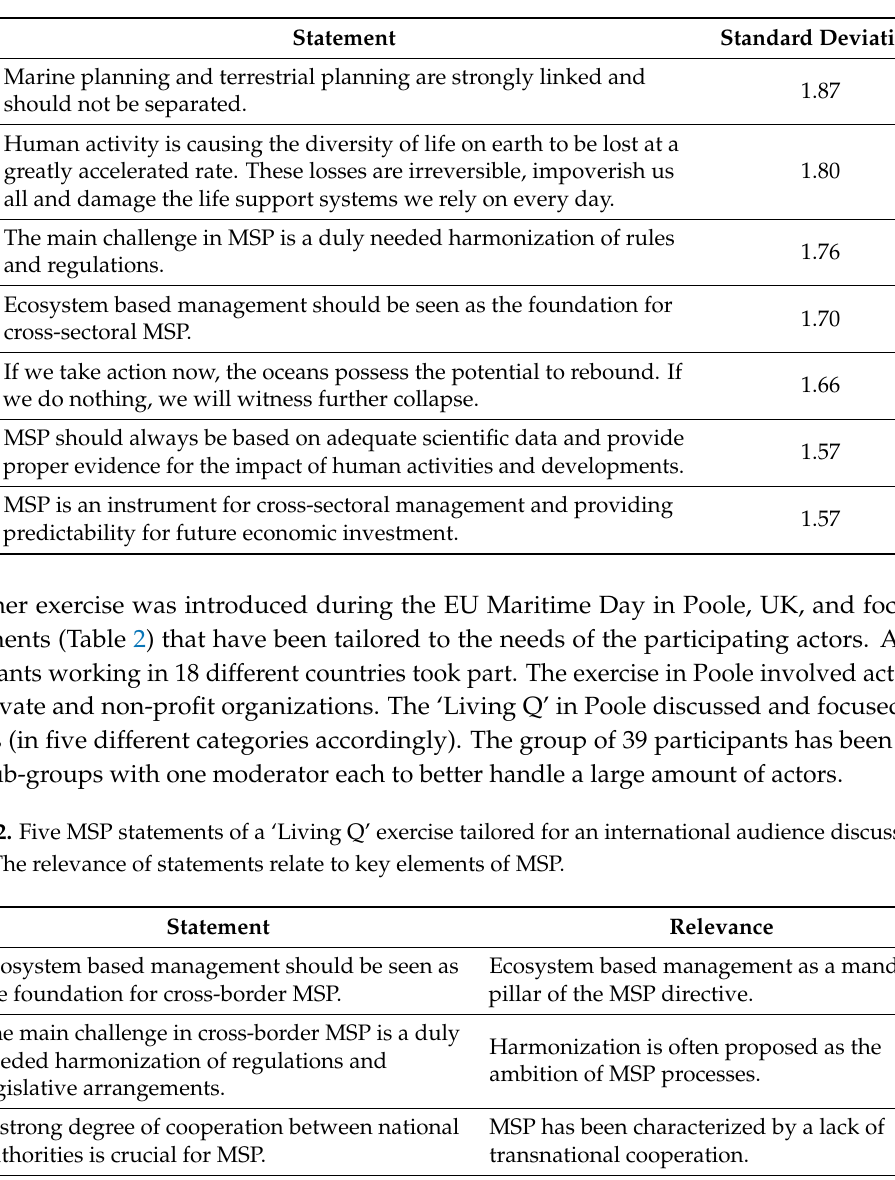
Table 1. Seven marine spatial planning (MSP) statements of the first ‘Living Q’ exercise with highest standard deviation.